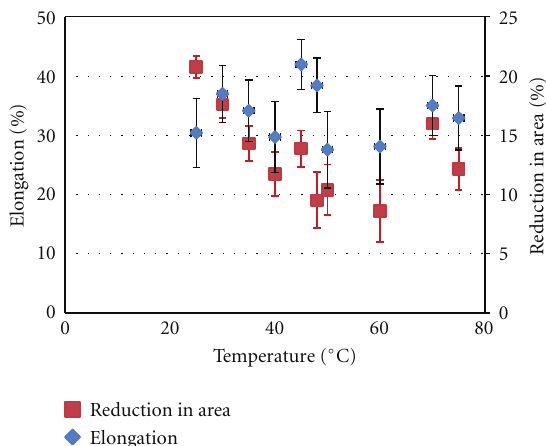
Figure 7: Elongation and reduction in area as a function of temperature for specimens machined transverse to the rolling direction, at 800kPa with a gas mixture of 50% CO and 50% CO 2 .